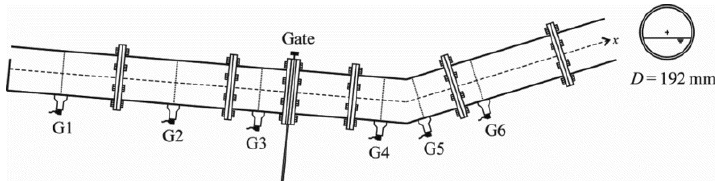
Figure 23. A sketch of the experimental setup, drawn by Aureli et al. [25].